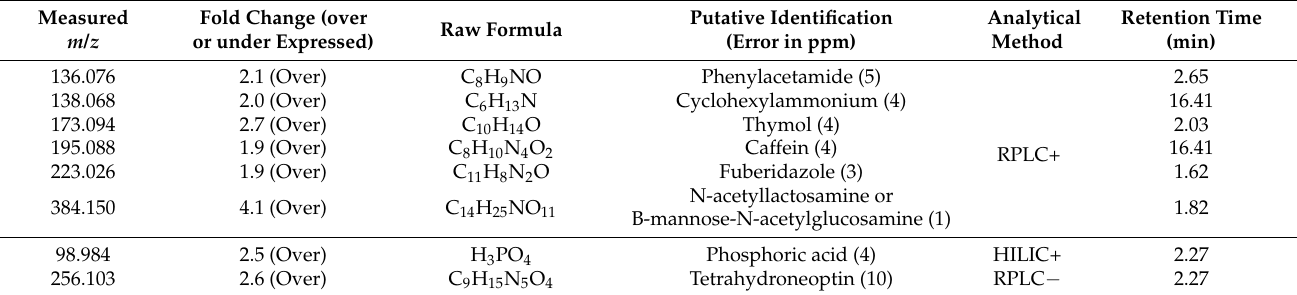
Figure 3. Extracted ion chromatograms for succinic acid ( m / z 117.020), hypoxanthine ( m / z 137.047), and linoleic acid ( m / z 279.240) analytical standards and for the corresponding compounds in the saliva of young and elderly people: ( a ) succinic acid in HILIC/MS–, ( b ) succinic acid in RPLC/MS+, ( c ) hypoxanthine in RPLC/MS+, and ( d ) linoleic acid in RPLC/MS–. Table 2. Potential salivary metabolites identified with